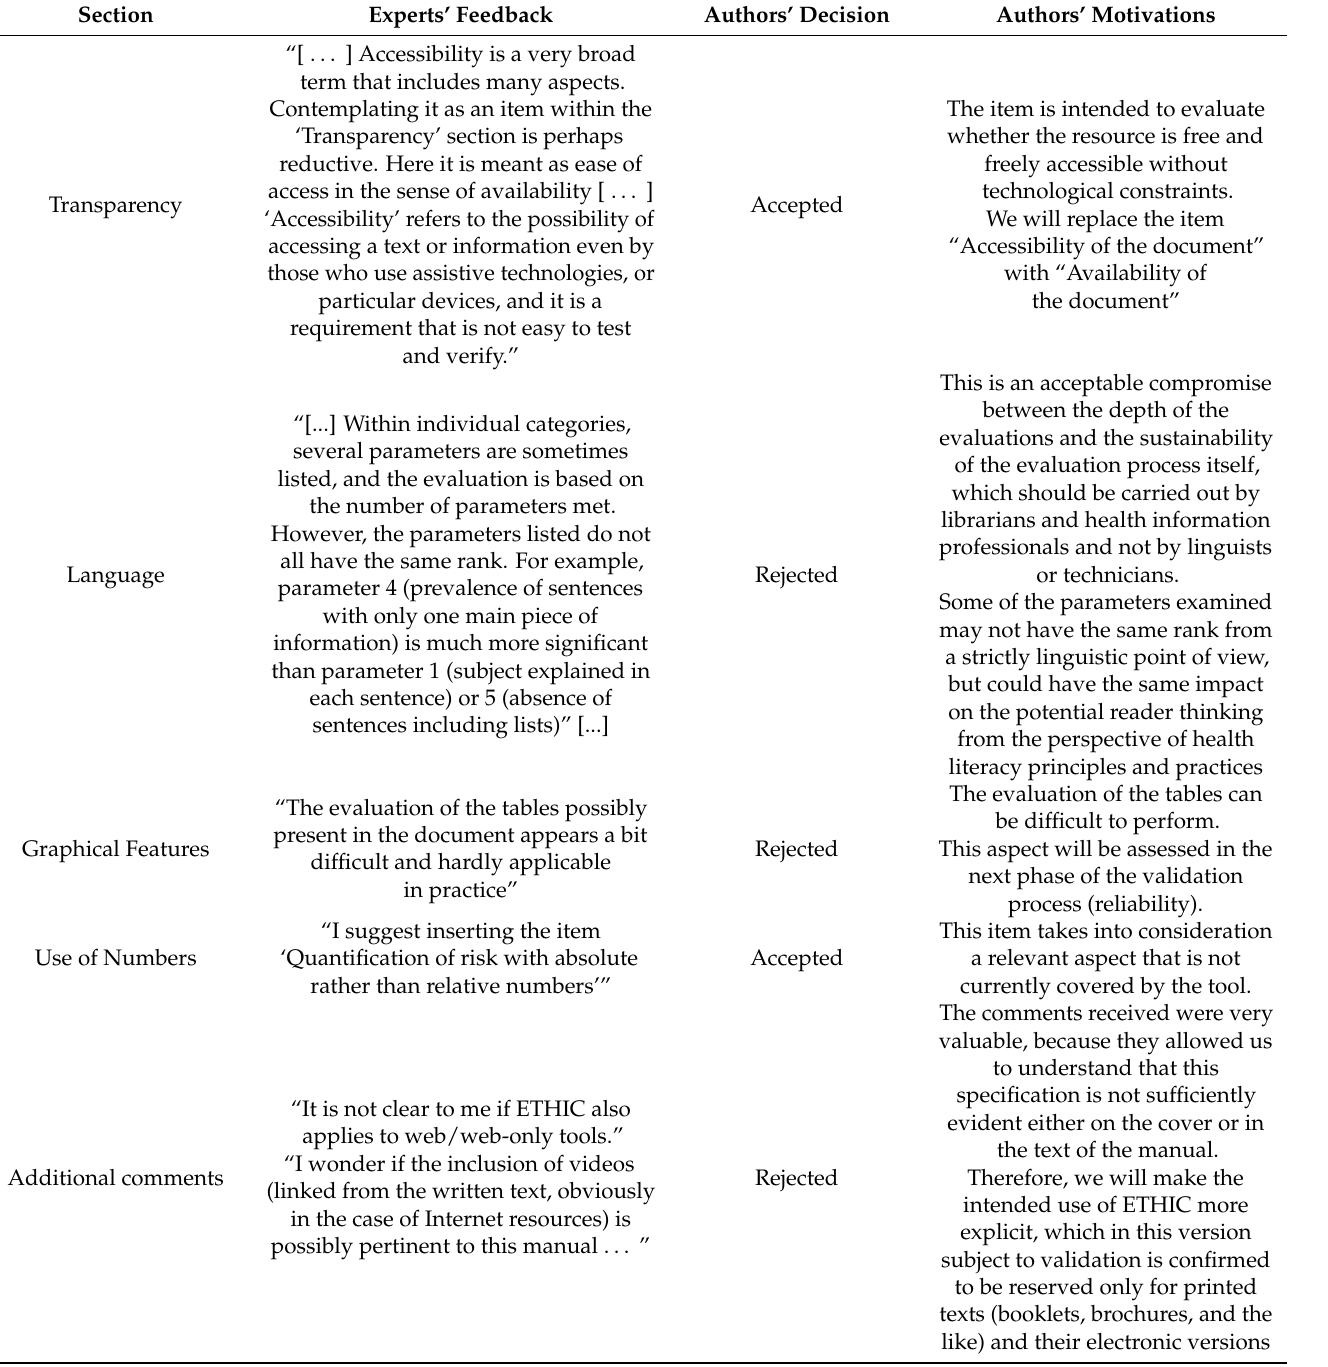
Table 1. Examples of experts’ feedback from different sections of the content validation form, and decisions made by